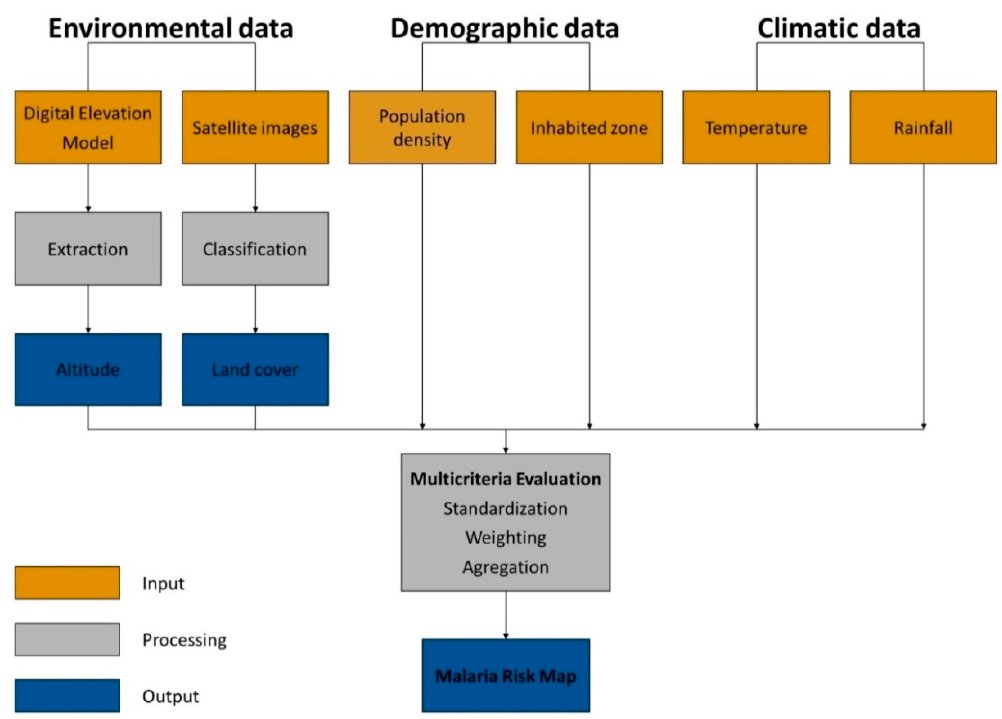
Figure 2. Workflow of the adopted spatial multi-criteria evaluation (MCE) process.